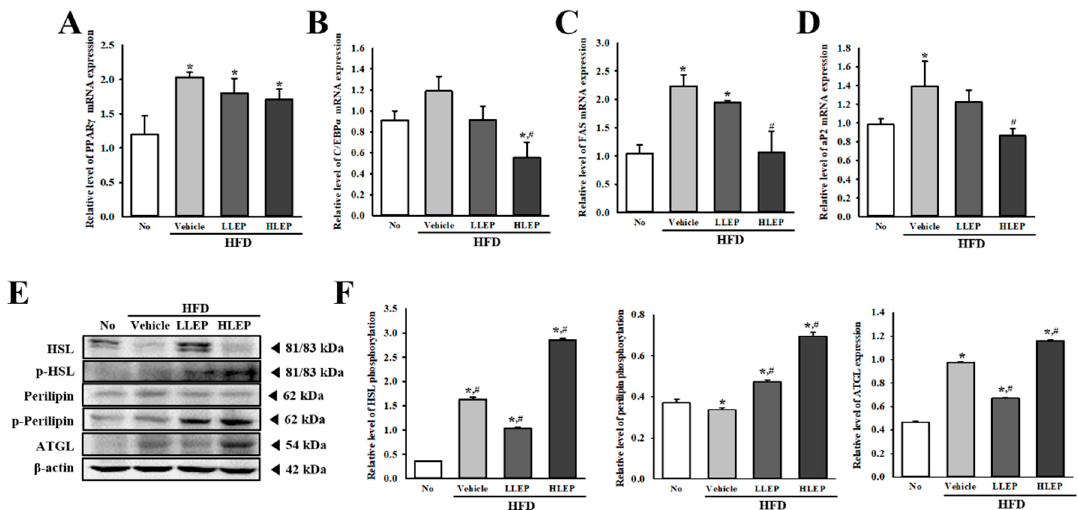
Figure 4. Expressions of lipogenesis associated genes and lipolysis associated proteins in liver tissue. HFD-induced obesity C57BL / 6N mice were treated with No, Vehicle, LLEP, or HLEP for 16 weeks. RT-qPCR using specific primers was performed to analyze the expression levels of genes associated with ( A , B ) adipogenesis, and ( C , D ) lipogenesis in the liver. Three to five mice per group were used in the preparation of total RNA, and RT-qPCR were assayed in duplicate for each sample. ( E , F ) Western blot analysis was performed to detect the phosphorylation or expression of several lipolysis-associated proteins, including perilipin, p-perilipin, hormone-sensitive lipase (HSL), p-HSL, and adipose triglyceride lipase (ATGL). The intensity of each band was determined using an imaging densitometer, and the relative levels of the four proteins were calculated based on the intensity of actin. Three to five mice per group were used in the preparation of liver tissue homogenate, and Western blot analyses were assayed in duplicate for each sample. Data represent the mean ± SD. * p < 0.05 compared to the No-treated group. # p < 0.05 compared to the HFD + Vehicle-treated group. Abbreviations: HFD, high-fat diet; LLEP, low concentration of LEP; HLEP, high concentration of LEP; RT-qPCR, reverse transcription-quantitative polymerase chain reaction; HSL, hormone-sensitive lipase; ATGL, adipose triglyceride lipase.